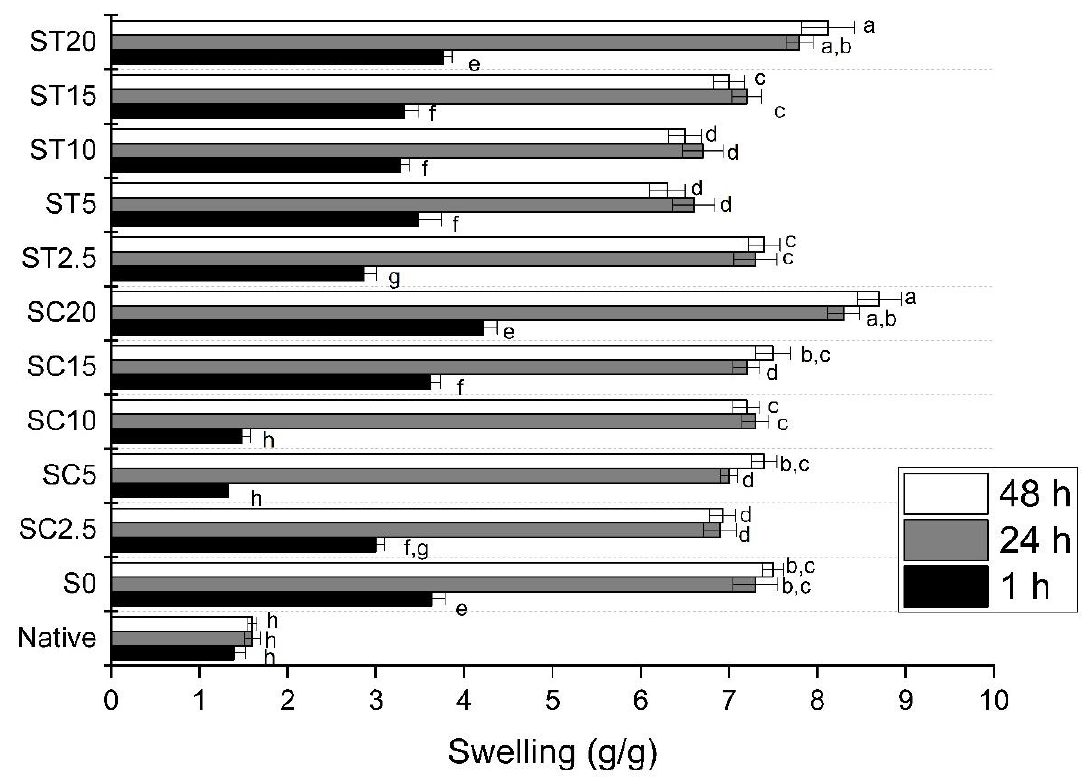
Figure 4. Effect of time on swelling of native starch, the control sample (extruded without reagent) and starch hydrogels obtained by reactive extrusion through reaction with CA and TA. Different letters indicate significant difference between means by Tukey’s test ( p ≤ 0.05).